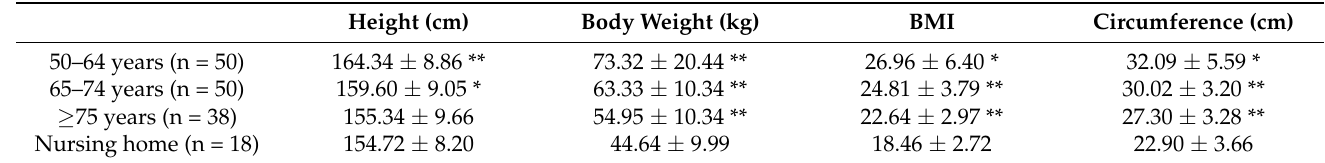
Table 2. Body size background (height, body weight, BMI, and circumference of upper arm).